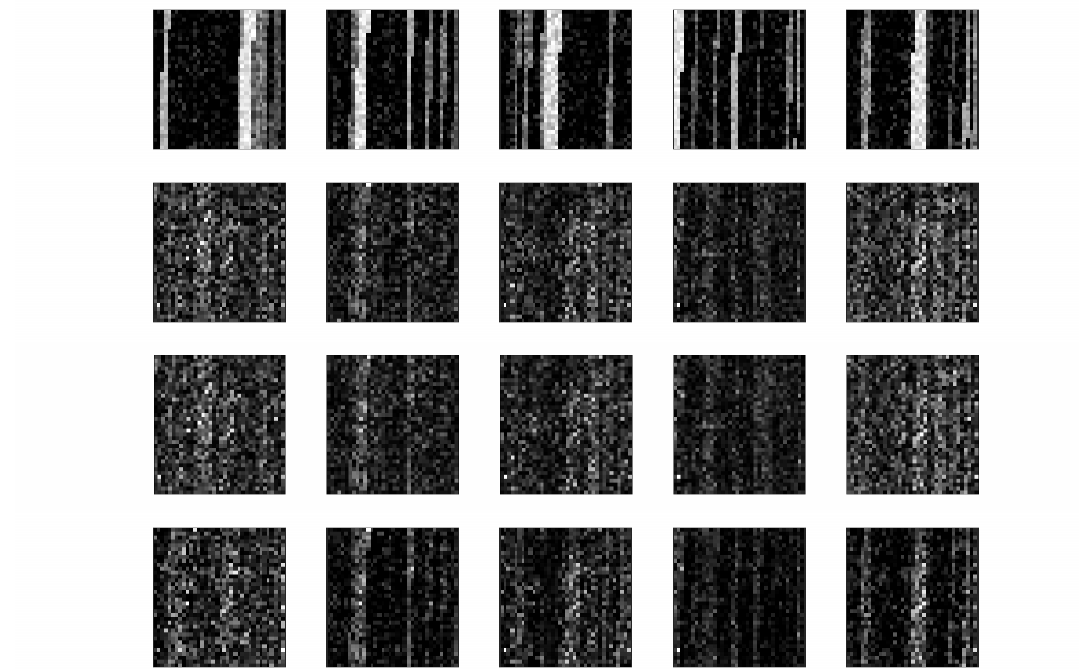
Figure 4. Abundance estimation errors with simulated data with 5 endmembers (SNR = 10 dB). The first row shows the ground truth abundances for the 5 classes. From the top, then the error in abundances as estimated by the hybrid, VCA and GBM methods, respectively.